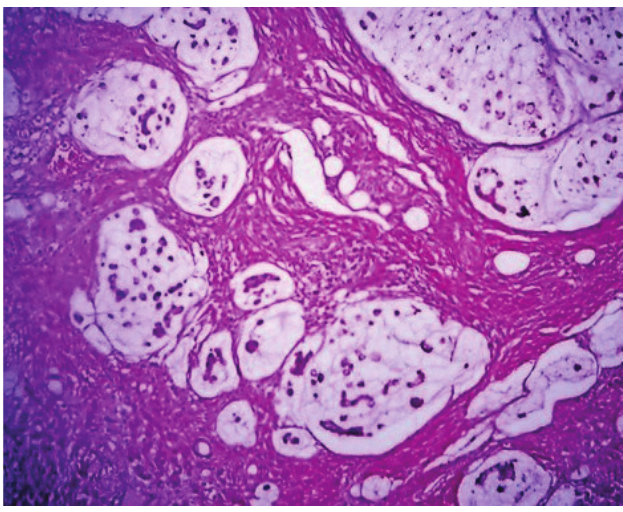
FigurE 2 − Photomicrograph showing solid areas and areas with mucinous differentiation in urethral adenocarcinoma